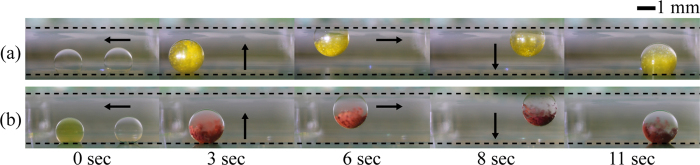
Precipitate formation reaction on the 3D DMF platform with patterned electrodes.(a) Formation of a yellow precipitate of lead (II) iodide (PbI2). The left and right droplets contain aqueous solutions of lead (II) nitrate [Pb(NO3)2] and potassium iodide (KI), respectively. (b) Formation of a red precipitate of silver chromate (Ag2CrO4). The left and right droplets contain aqueous solutions of potassium chromate (K2CrO4), and silver nitrate (AgNO3), respectively. The dashed line and arrow indicate the electrode plate and the moving direction of the droplets, respectively.